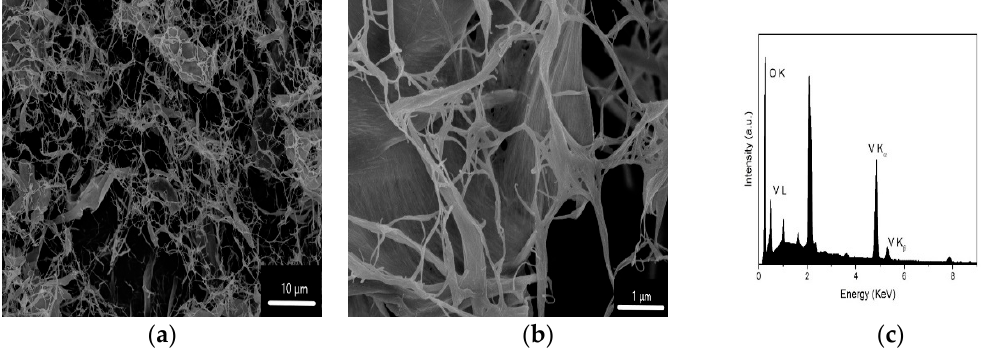
Figure 2. SEM images ( a ) and ( b ) and selected area EDX analysis ( c ) of V 2 O 5 nanofiber clusters.